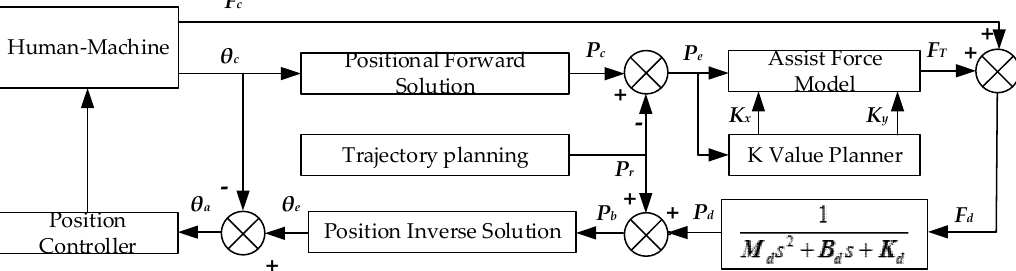
Figure 7. Assistance training control block